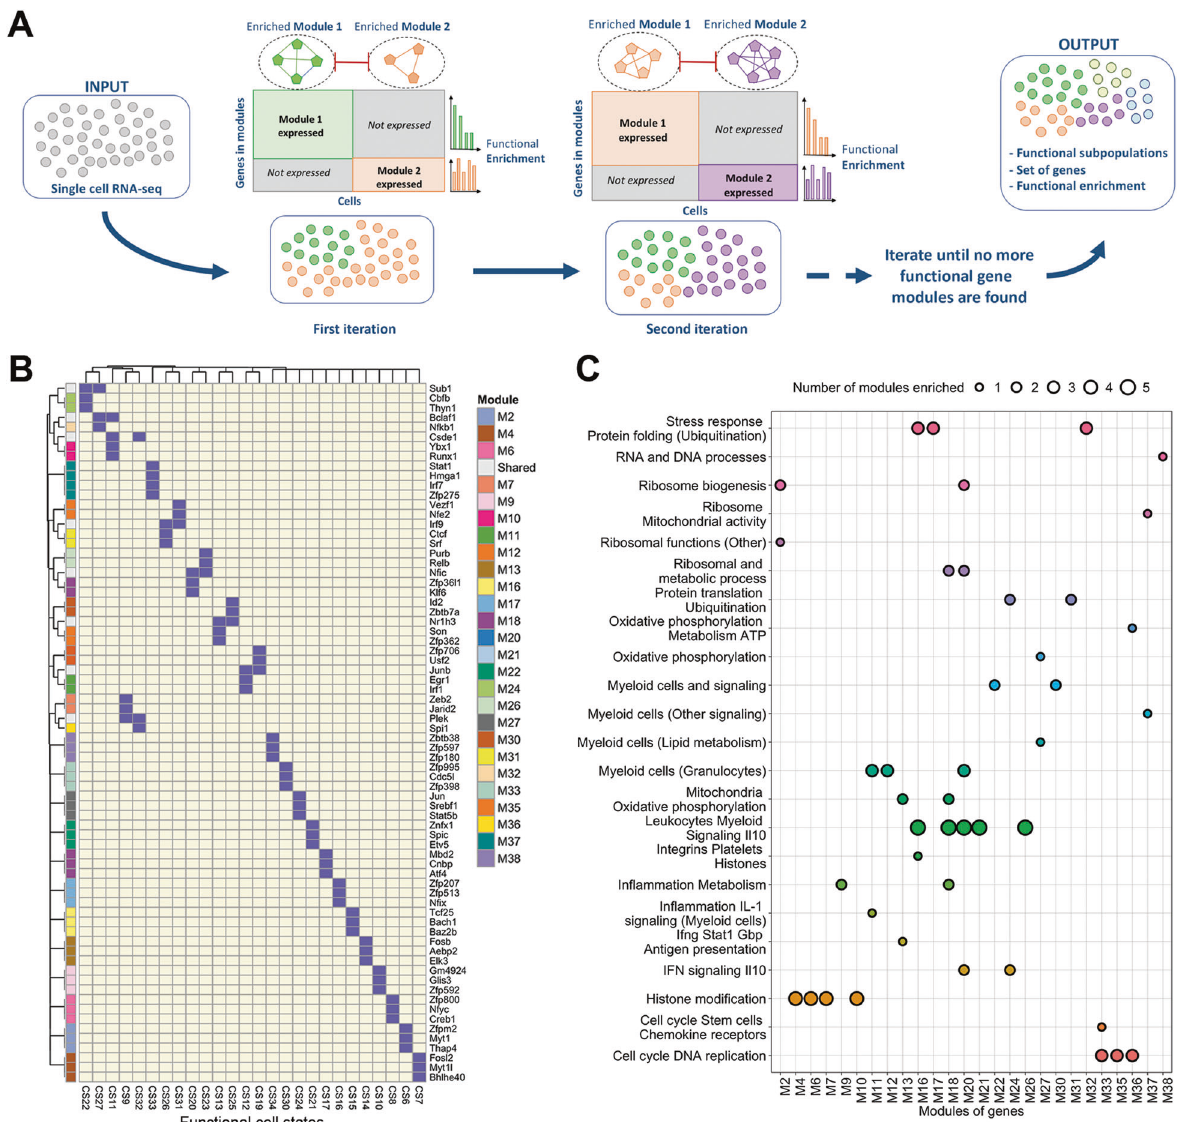
Fig. 1 FunPart general work fl ow and validation. A General work fl ow of the functional states identi fi cation and characterization. The computational method we developed, named FunPart, takes single-cell RNA-seq data of one cell type as an input, to identify functional states based on functional modules of genes. The method searches for modules exclusively expressed in one group of cells and belonging to the same immune process. Cells are recursively splitted in two groups until no more functionally relevant modules associated to new states can be found. B Binary heatmap of the 26 terminal genes modules identi fi ed by FunPart for the macrophages functional cell states CS. Only TFs are displayed. C Functional enrichment of these 26 terminal gene modules. Each immune process has a different color, the size of the dots represents the number of gene modules enriched in the speci fi c process. Intermediate gene modules are not